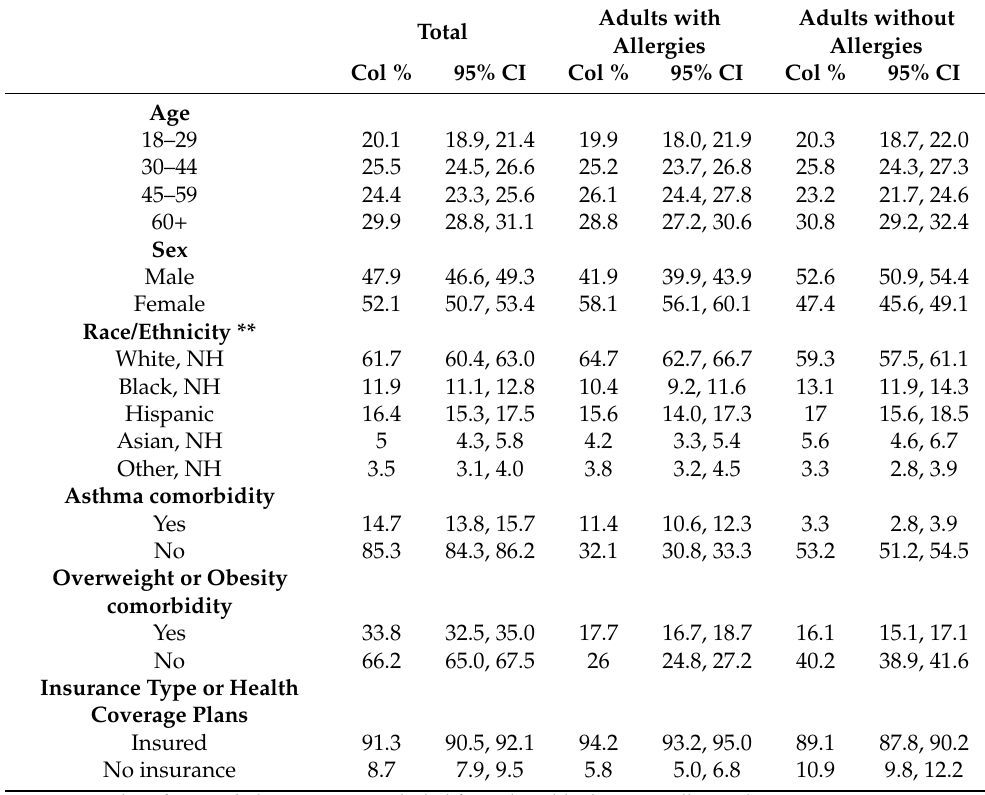
Table 1. Characteristics of COVID Impact Survey respondents ( n = 10,760), a nationally representative survey of the US, stratified by allergy diagnosis (April–June 2020).